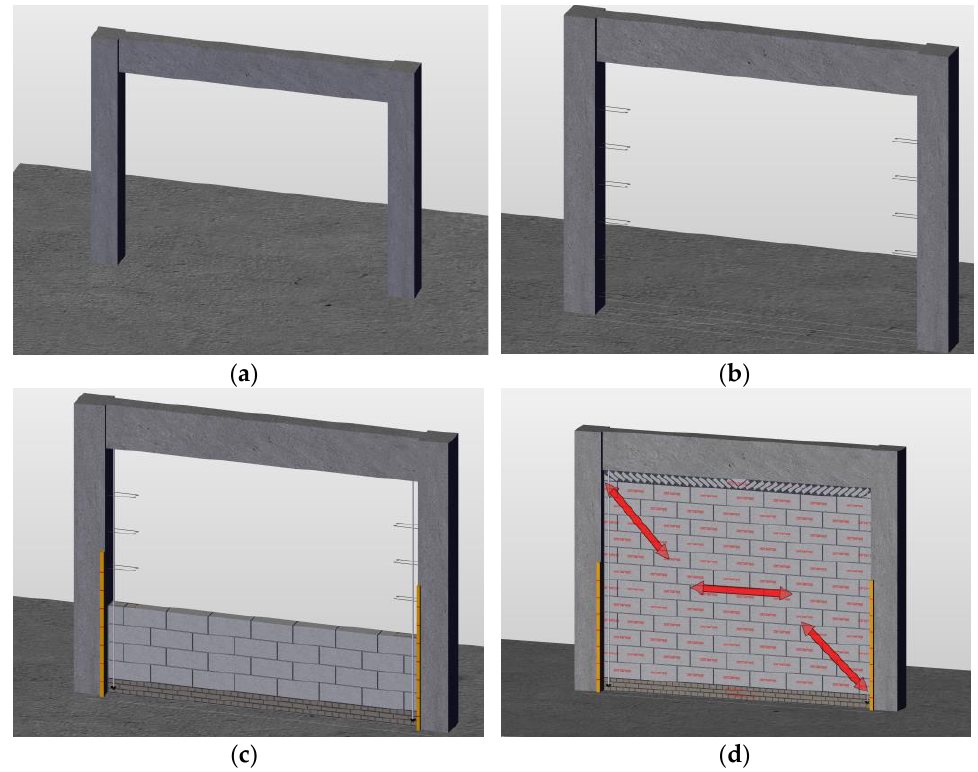
Figure 7. The set of key views of the infill wall masonry construction technology: ( a ) preliminary stage; ( b ) tie-bar implanting in wall; ( c ) wall masonry; ( d ) flatness check.